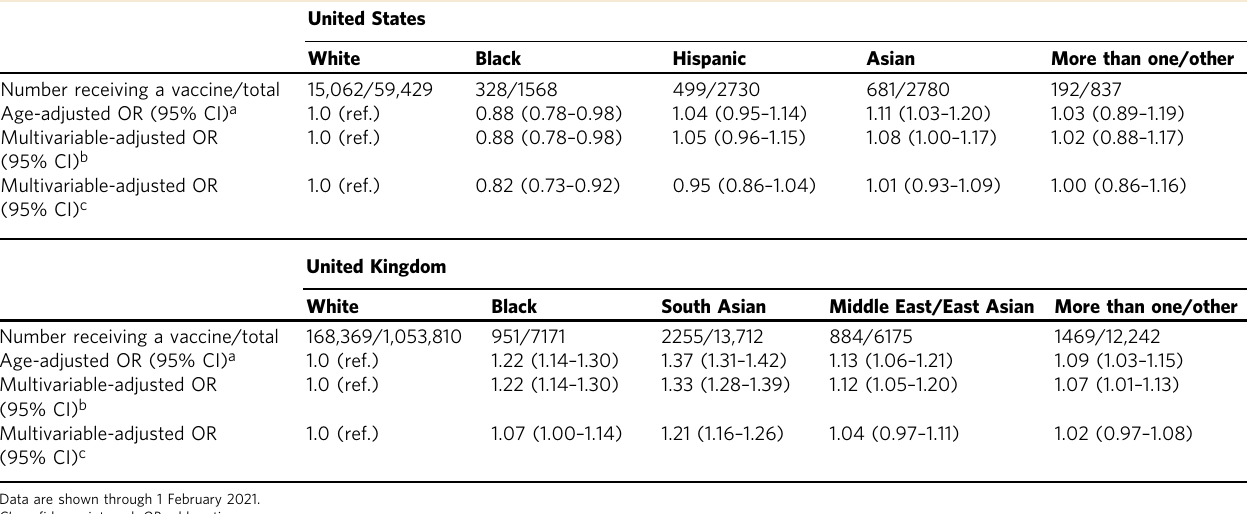
Table 3 Vaccine uptake by race and ethnicity according to country of enrollment among the vaccine-willing.